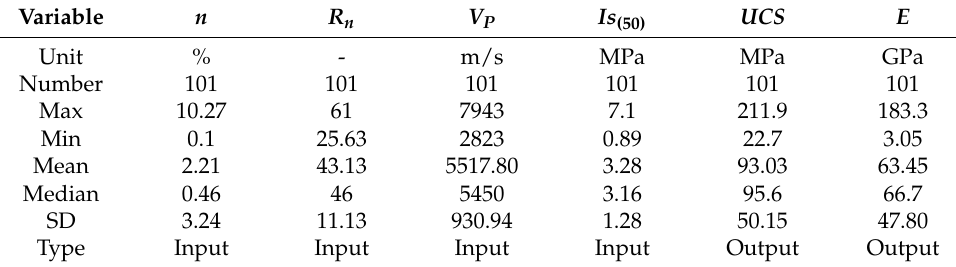
Table 1. Mathematical statistical characteristics of the